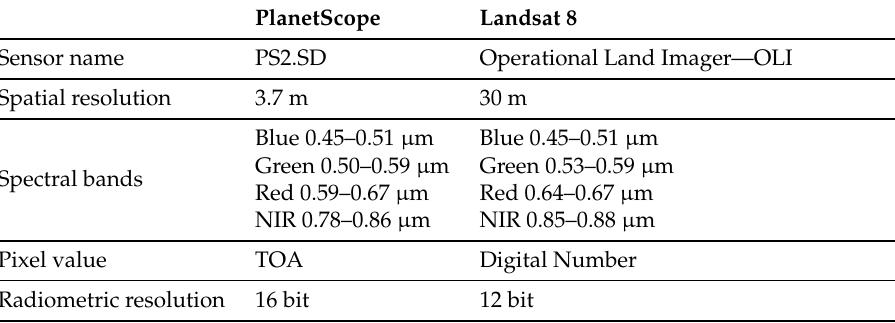
Table 2. Comparison between PlaneScope [33] and Landsat 8 [34]